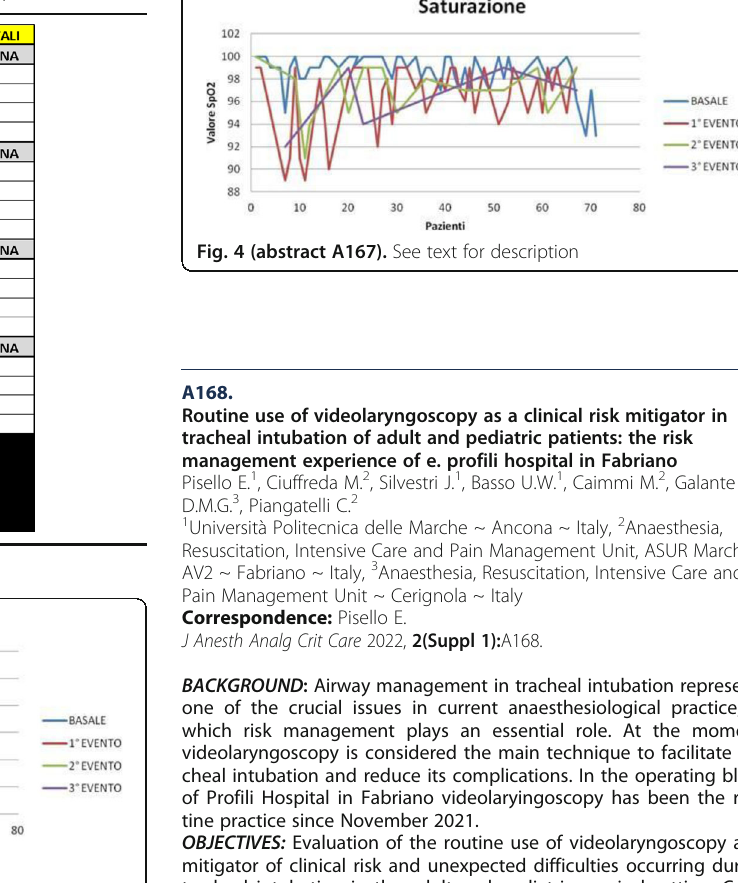
Table 3 (abstract A167). Sezione specifica, statistiche parametri